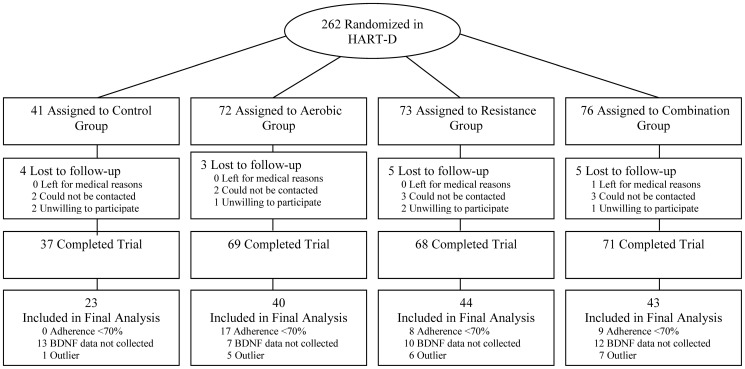
Consort diagram.